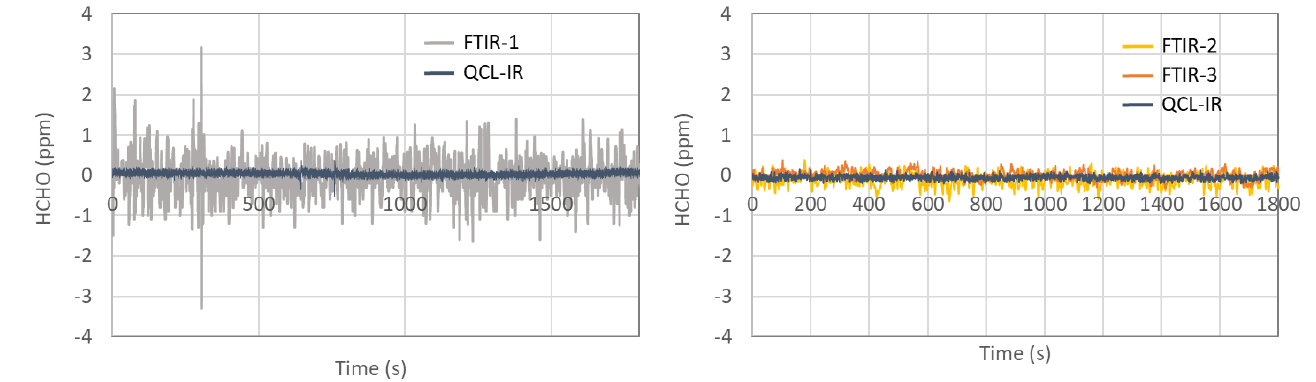
Figure 4. ( Left panel ) HCHO emission profiles of the DV during a hot-start WLTC at 0°. ( Right panel ) HCHO emission profiles of the HDV during a hot-start WHVC at 5 °C.